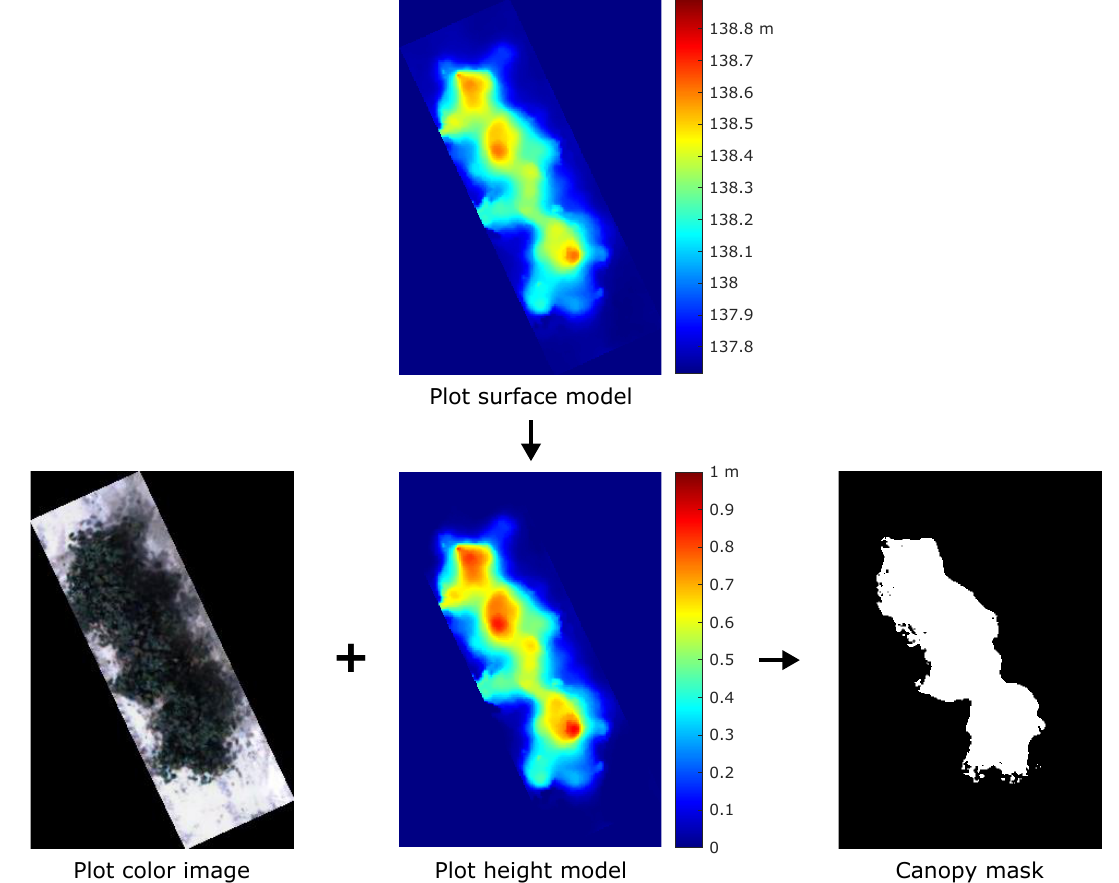
Figure 18. Illustration of a canopy segmentation result. The plot surface model was first subtracted by the ground plane to derive a plot height model. The canopy mask was generated by thresholding the RGB image and the height model for the plot.